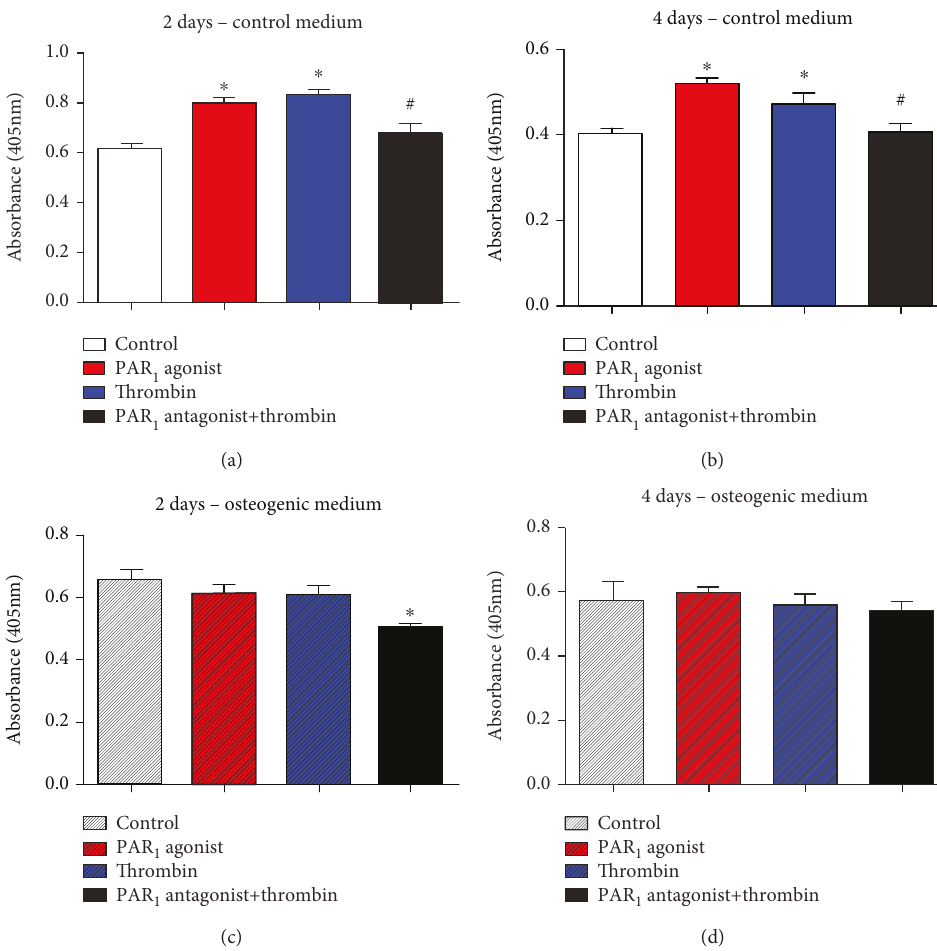
Figure 5: Cell proliferation in di ff erent groups. Values are presented as mean and SEM; n = 3 . ∗ Mean signi fi cant di ff erence when compared to control of the same medium and time point ( p < 0 05 ). # Mean signi fi cant di ff erence when compared to thrombin treatment of the same medium and time point ( p < 0 05